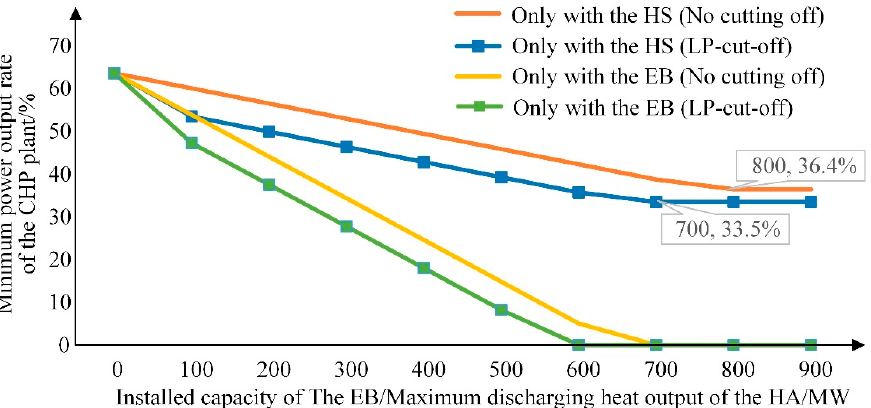
Figure 5. The influence of flexible heating devices parameters on power output rate of the CHP plant.